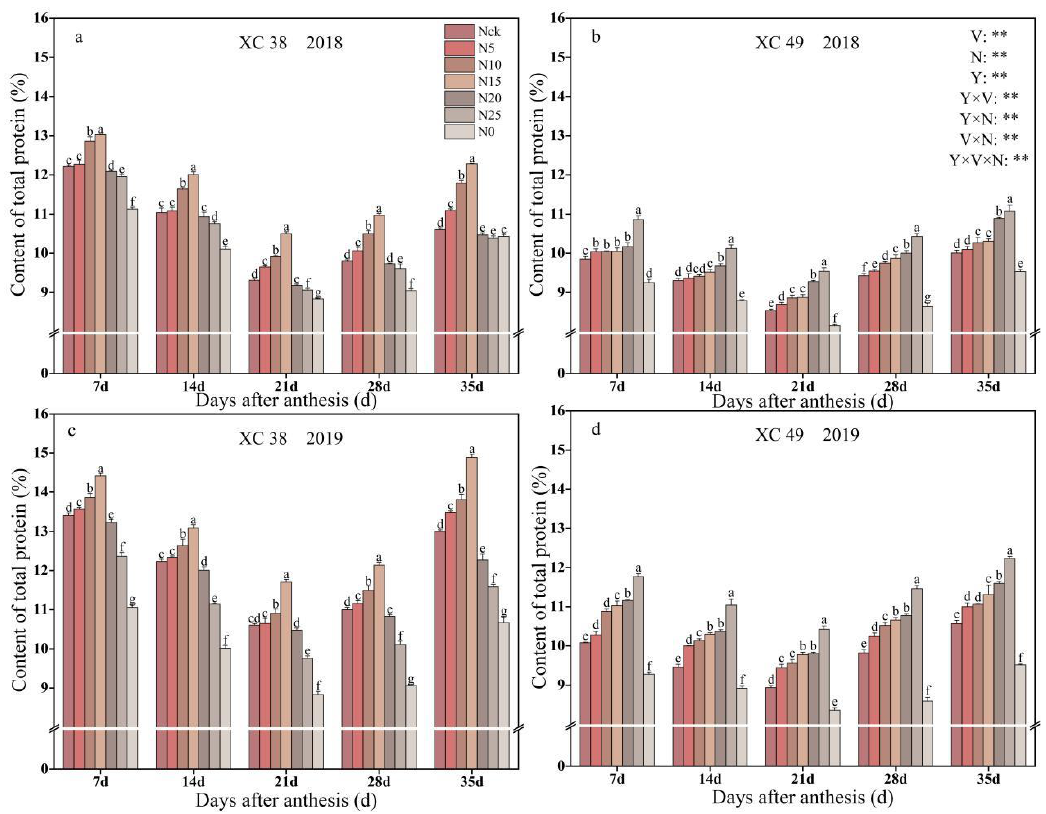
Figure 5. Effects of different nitrogen treatments on total protein in grain in 2018 and 2019. ( a ) Total protein of XC 38 grains in 2018; ( b ) Total protein of XC 49 grains in 2018; ( c ) Total protein of XC 38 grains in 2019; ( d ) Total protein of XC 49 grains in 2019. XC 38: Xinchun 38; XC 49: Xinchun 49; Nck: 300 kg hm −2 , N5: 285 kg hm −2 , N10: 270 kg hm −2 , N15: 255 kg hm −2 , N20: 240 kg hm −2 , N25: 225 kg hm −2 , N0: 0 kg hm −2 ; V: Variety, N: Nitrogen, Y: Year. ** represents significant differences at 0.01